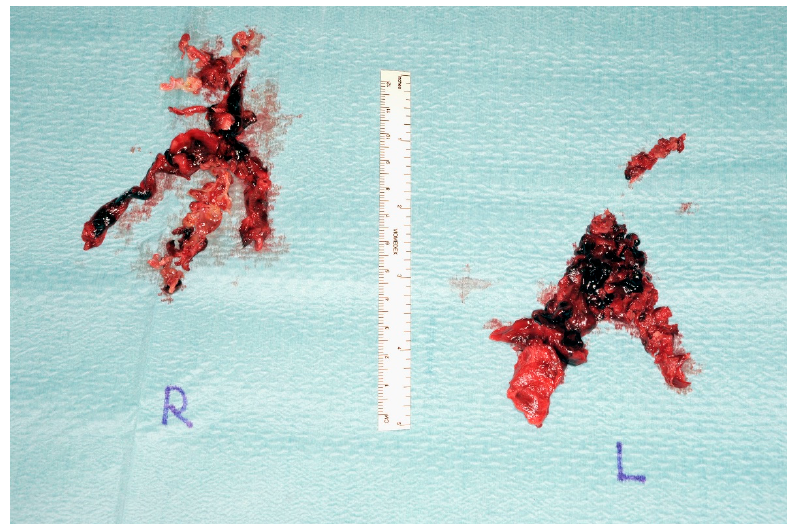
Figure 7. Transesophageal echocardiography: D-shaping (red arrow) in midesophageal 4 chamber ( A , B ); transgastric short-axis views at end systole ( A ) and end diastole ( B ).